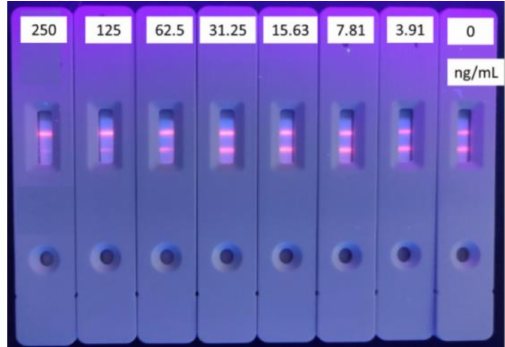
Figure 3. Standard curve for tylosin with the amount of MAb 32 µ g ( n = 3). (Dosage of coating